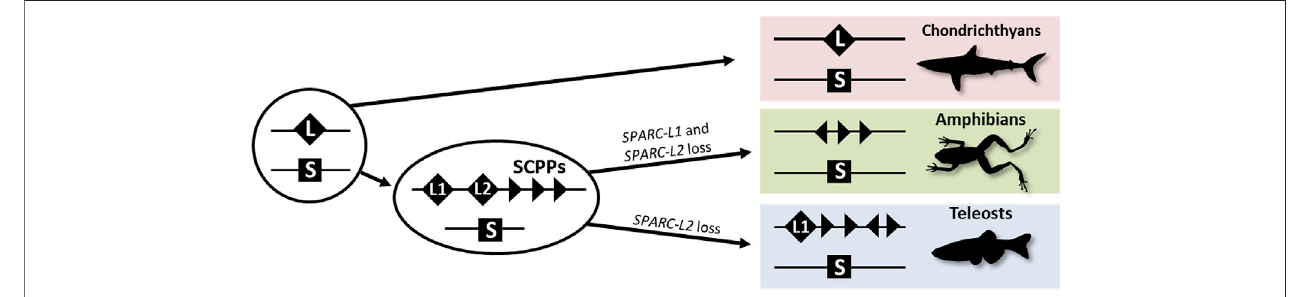
FIGURE 1 | A simpli fi ed evolutionary scenario for the SPARC / SPARC-L / SCPP family. Vertebrate-speci fi c whole genome duplications produced the ancestral SPARC (S) and SPARC-L (L) paralogues. These loci were not overtly altered in the chondrichthyan lineage as both genes are clearly identi fi able in sharks. In the osteichthyan lineage, local duplications at the SPARC-L locus produced SPARC-L1 (L1), SPARC-L2 (L2) and the SCPP members (triangles). Triangles in different orientations symbolize the fact that SCPP genes are subject to independent local duplications events and a high rate of evolutionary divergence, hindering homology relationships. SPARC-L2 was independently lost in tetrapods and teleosts and SPARC-L1 was also lost in amphibians. See text for details and references.